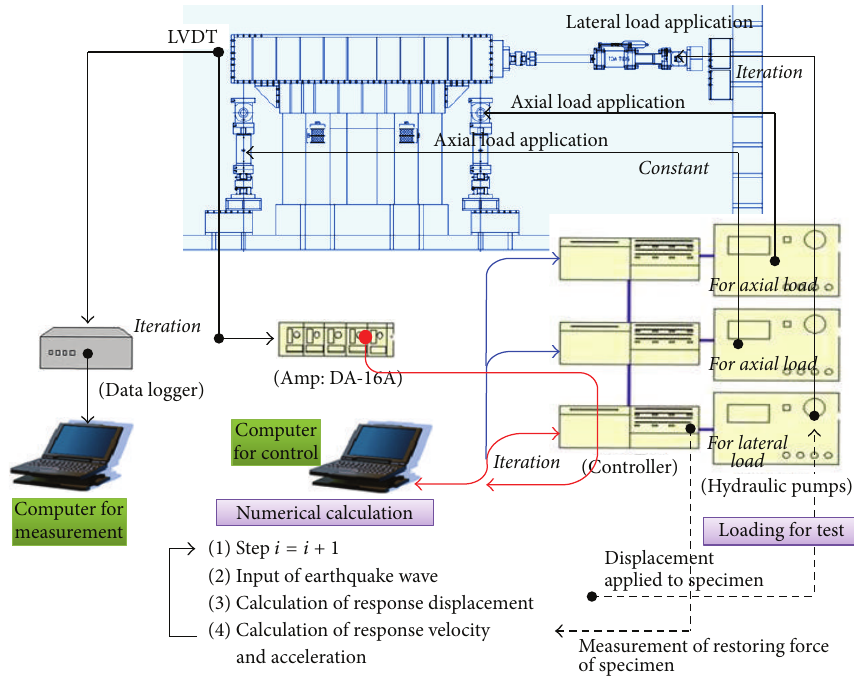
Figure 7: Simplified schematic diagram of the pseudodynamic testing